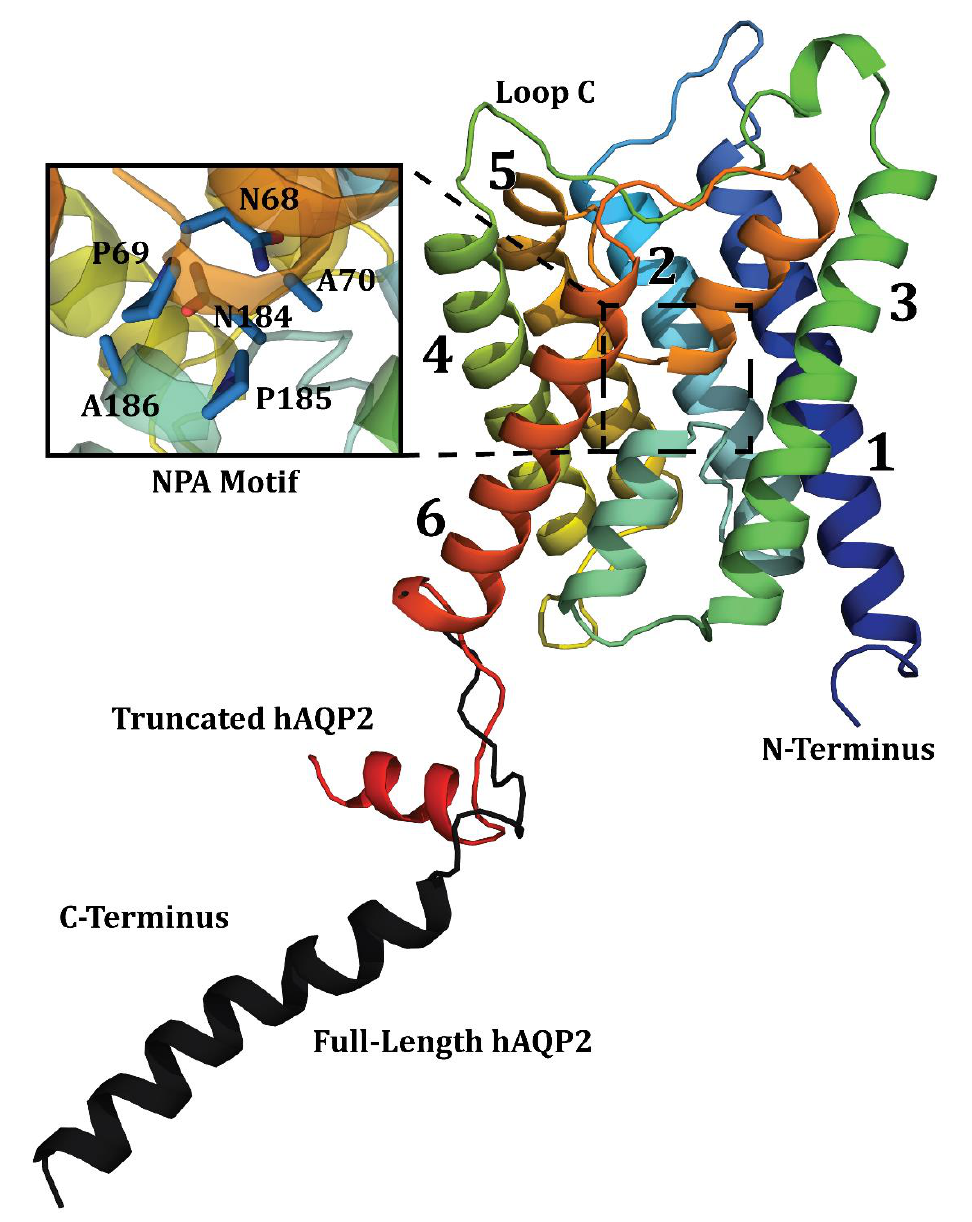
Figure 9. X-ray crystallographic structure of hAQP2 with major structural features identified. Helices are denoted 1–6 and loop C is indicated. Figure combines the truncated wild-type structure PDB ID 4NEF [58], and the C-terminal tail of the S256A mutant structure PDB ID 4OJ2 [95] (Black). Figure was generated in PyMOL (The PyMOL Molecular Graphics System, Version 2.0 Schrödinger, LLC ).